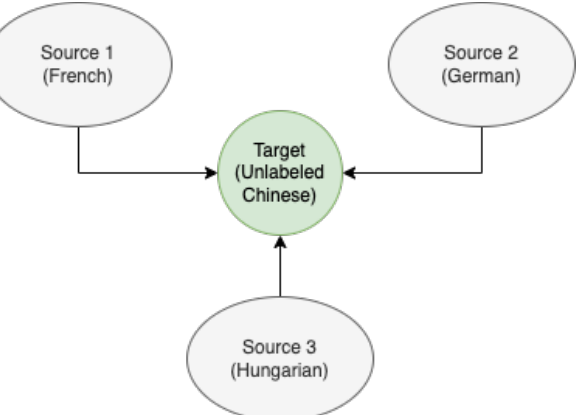
Figure 3. Proposed N-CORAL-based domain generalization strategy for cross-language